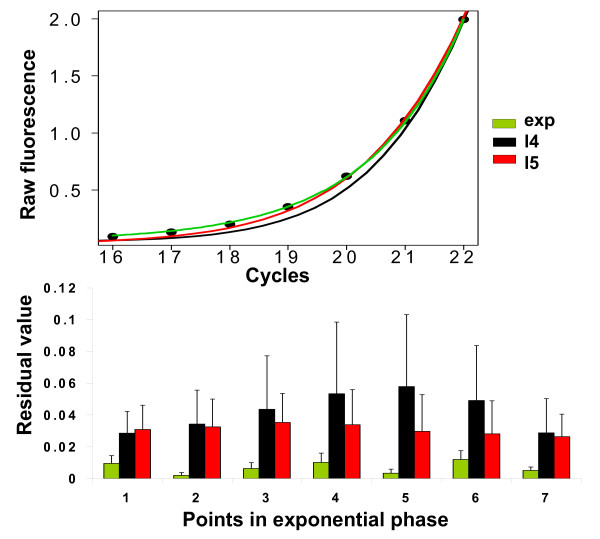
Goodness-of-fit in the exponential region of the amplification curve. Upper panel: Zoom-in view for the goodness of fit in the exponential region of a qPCR curve. Three different models were fit to the exponential region of a typical qPCR curve which was identified by the method described in [9]: An exponential model (green), a four-parameter log-logistic model (black) and a five-parameter log-logistic model (red). Lower panel: Residual values for seven points within the exponential regions of 24 qPCR data fits (six dilutions, four replicates each) for the three models. Colour coding same as above. Values are shown as mean + s.d.).